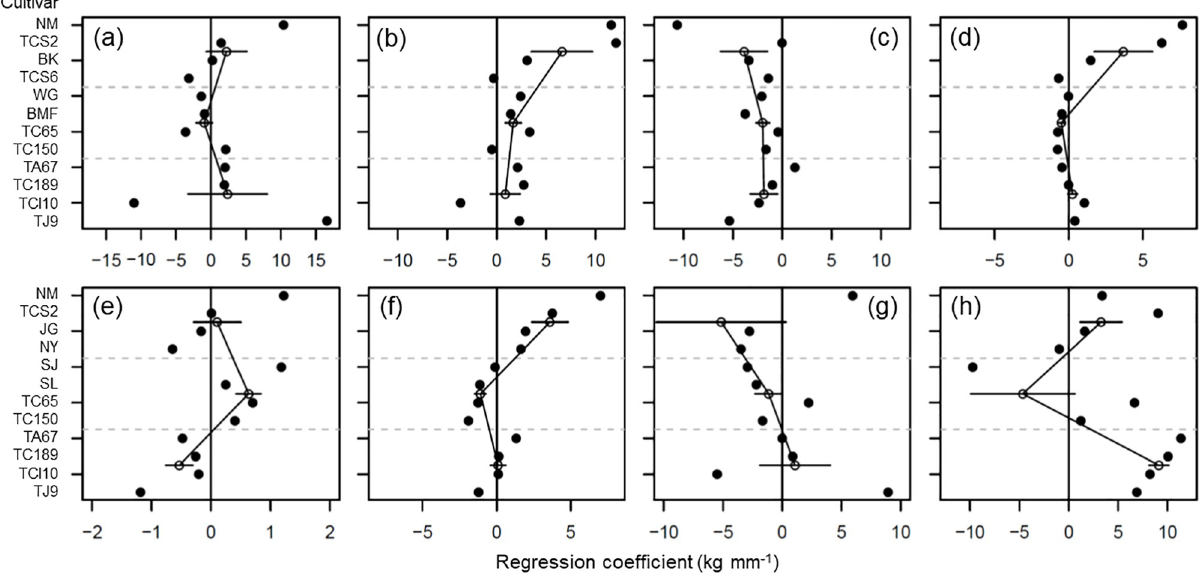
Fig 4. Regression coefficient of rice yield on crop water status under initial (a and e), crop development (b and f), reproductive (c and g), and maturity (d and h) stages in cool (a, b, c, and d) and warm (e, f, g, and h) cropping seasons. Filled circles represent the value of a cultivar. Open circles represent the average value of a group of cultivars having overlapped cultivation period. The length of the black line on the open circle represents the value of standard deviation. Horizontal dash lines separate the groups of cultivars having overlapped cultivation periods. In each panel, the upper, mid, and lower zone represent the periods of 1925–1944, 1945–1983, and 1996–2019, respectively.